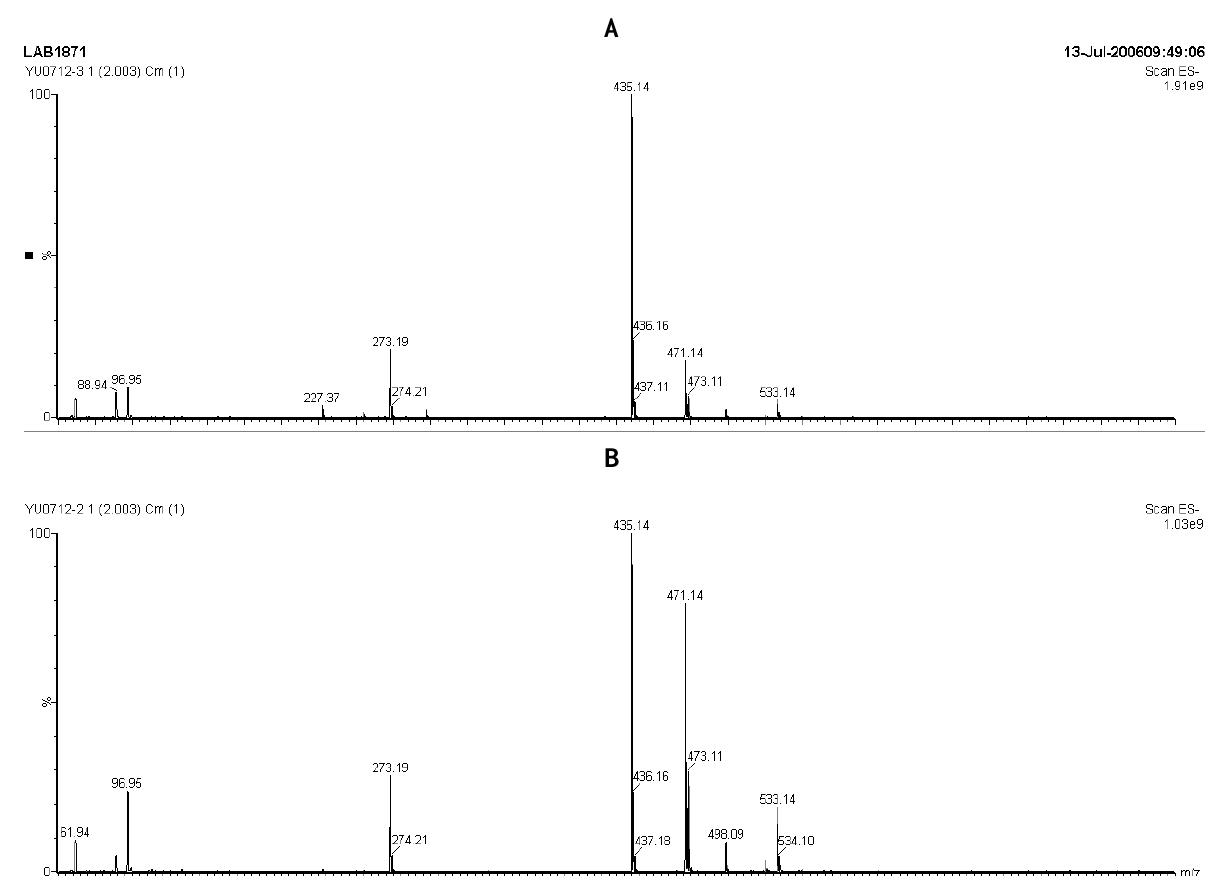
Figure 7. ESI-MS spectra of the [ M − H] - ion of (A) the target compound and (B) the phlorhizin